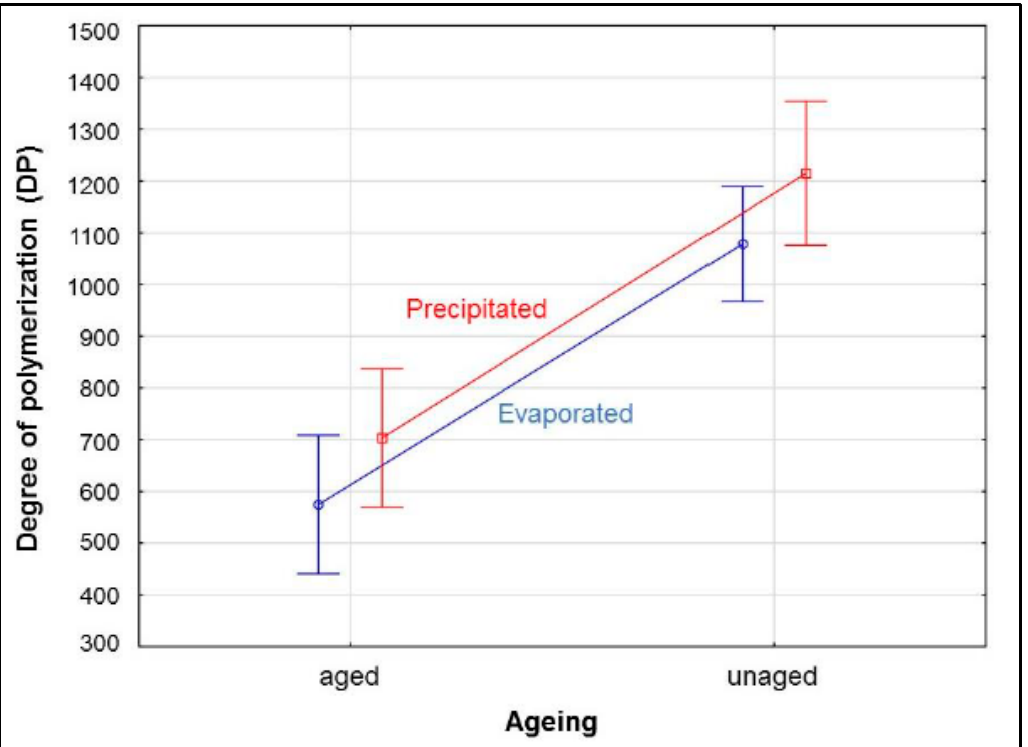
Figure 3. Influence of solution*method on the degree of polymerization in cellulose.